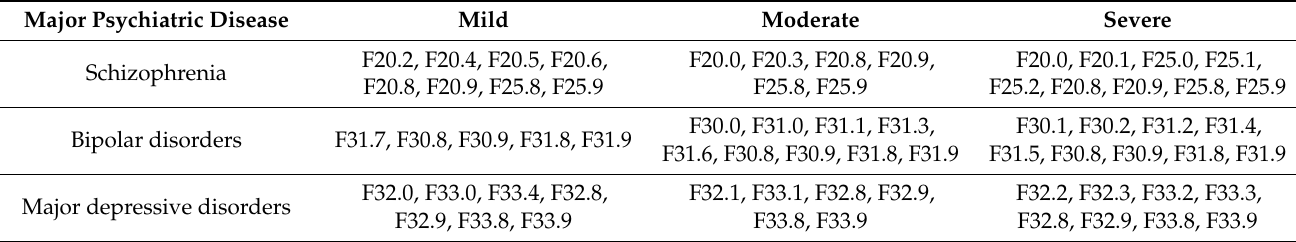
Table 2. Mapping of ICD-10 code-based severity